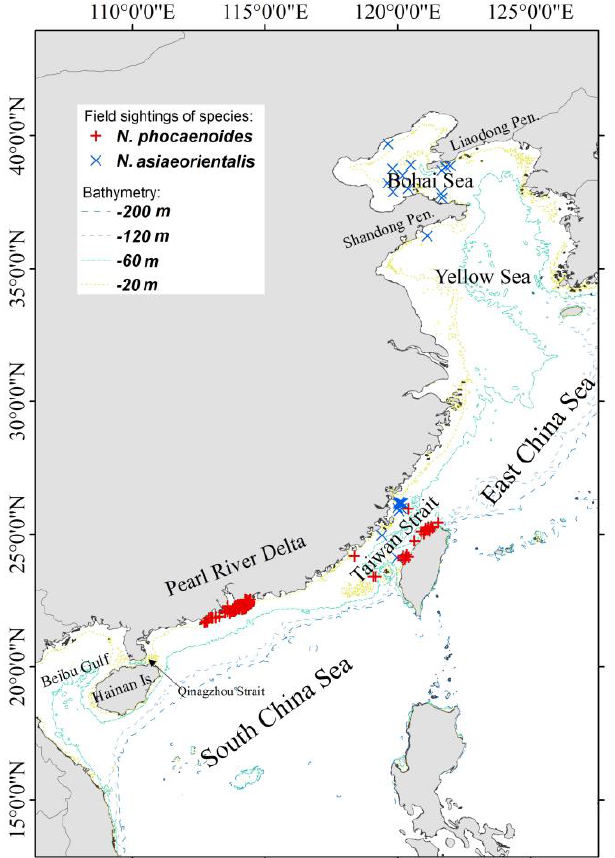
Figure 1. The distribution of samples obtained from finless porpoises in China’s coastal waters that were used in the present study, including both the narrow-ridged finless porpoise ( N. a. sunameri ) from Bohai Sea and wide-ridged finless porpoise ( N. phocaenoides ) from South China Sea (Pearl River Delta region). Data were also reconstructed for the two species occurring sympatrically in Taiwan Strait